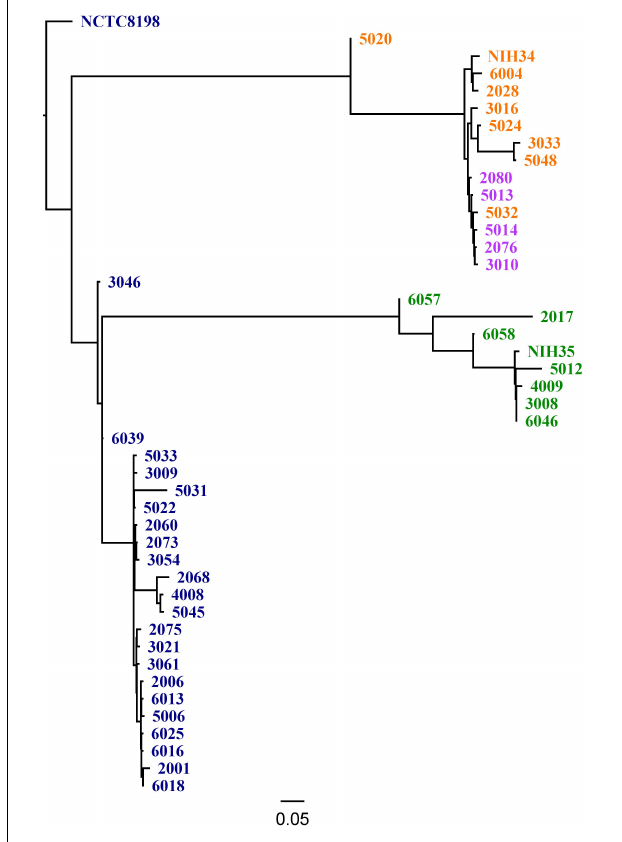
FIGURE 1 | Single nucleotide polymorphism (SNP) based Phylogeny using CSI Phylogeny 1.4, including the three most common emm types in the study and reference strains [NCTC8198 (GenBank accession LN831034.1), NIH34 (GenBank accession AP023387.1) and NIH35 (GenBank accession AP023388.1)]. The color indicates emm - and ST type, including dark blue: emm1 (ST 28); purple: emm3 (ST 15); orange: emm3 (ST 315) and green: emm28 (ST 52).